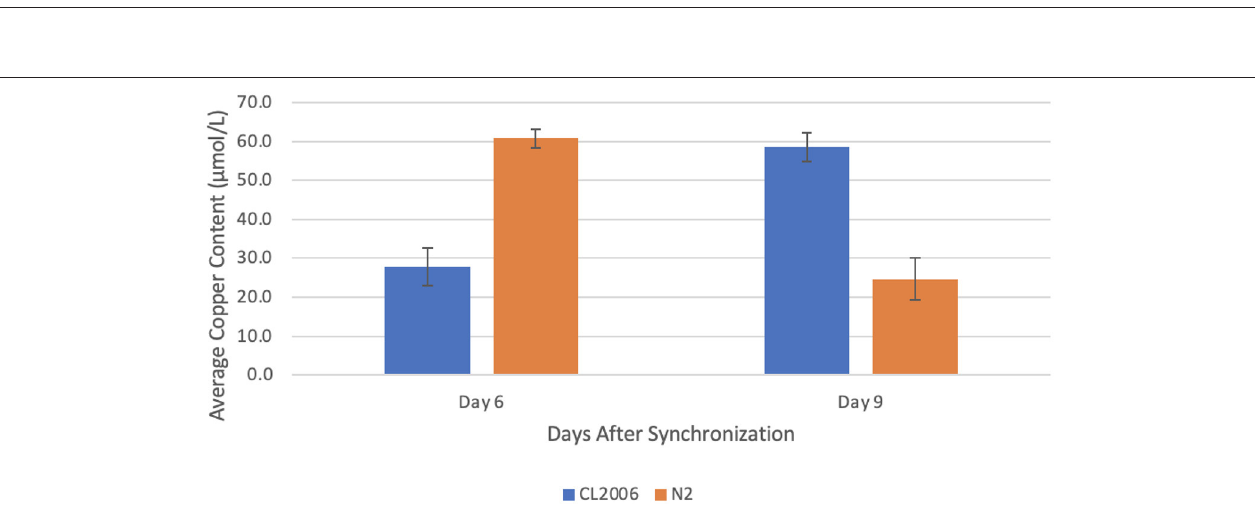
FIGURE 2 | Average copper content in C. elegans supplemented with zinc. When amyloid-beta producing C. elegans (CL2006) were supplemented with zinc, a statistically significant ( p = 0.022) increase in the average copper content occurred from day 6 (27.8 ± 4.9 µ mol/L) to day 9 (58.6 ± 3.7 µ mol/L). In contrast, when non-amyloid-beta producing C. elegans (N2) were supplemented with zinc, a statistically significant ( p = 0.012) decrease in the average copper content occurred from day 6 (60.8 ± 2.4 µ mol/L) to day 9 (24.7 ± 5.4 µ mol/L). Values are mean ± SEM and are representative of 2 experiments where 30 C. elegans were analyzed at each time